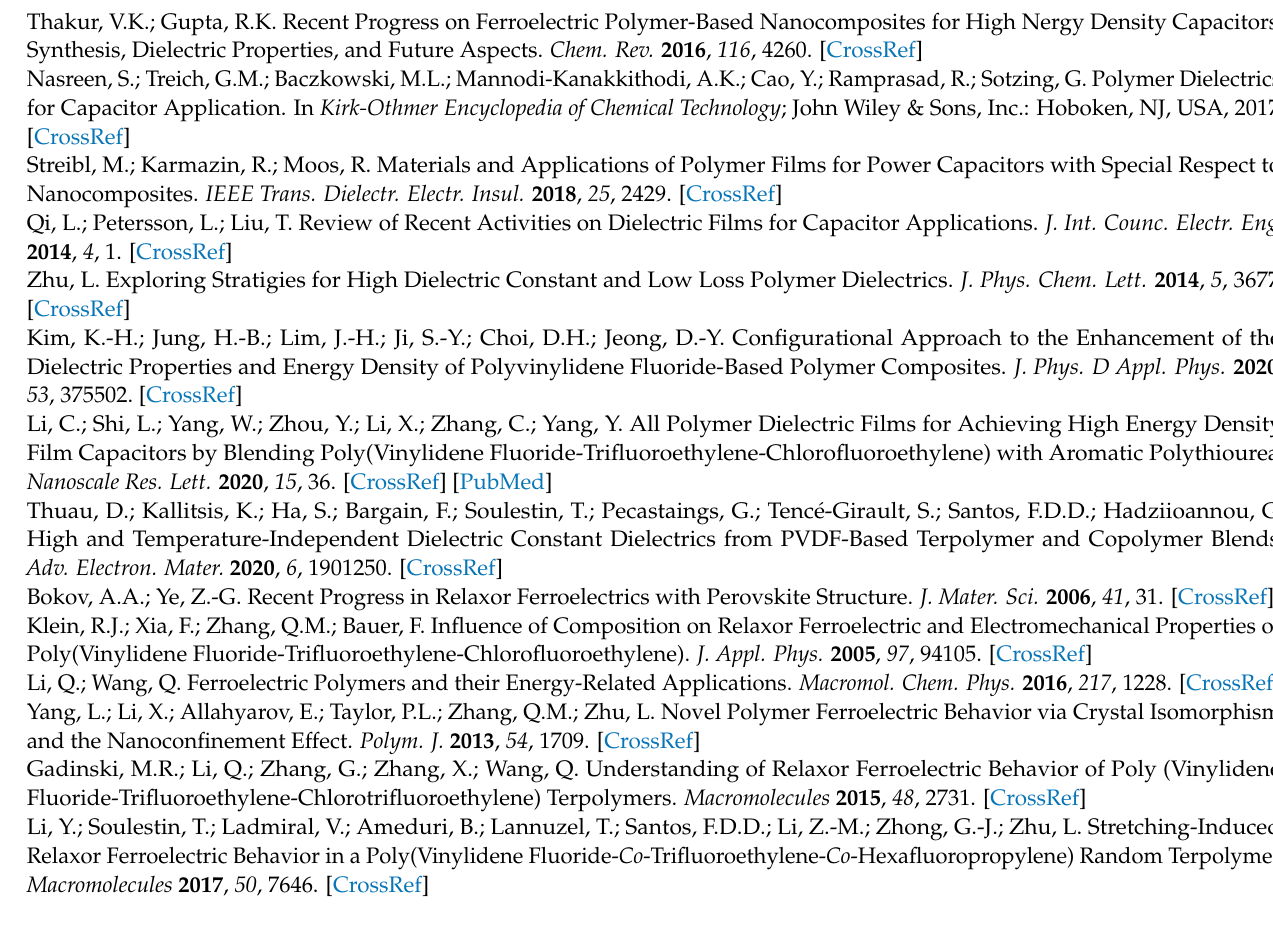
indicating the studied compositions, Figure S2: Heat flow curves measured by DSC upon heating (above) and cooling (below), where the peaks correspond to melting and recrystallization, respectively, Figure S3: Unipolar polarization hysteresis curves measured as a function of voltage at 10 Hz and room